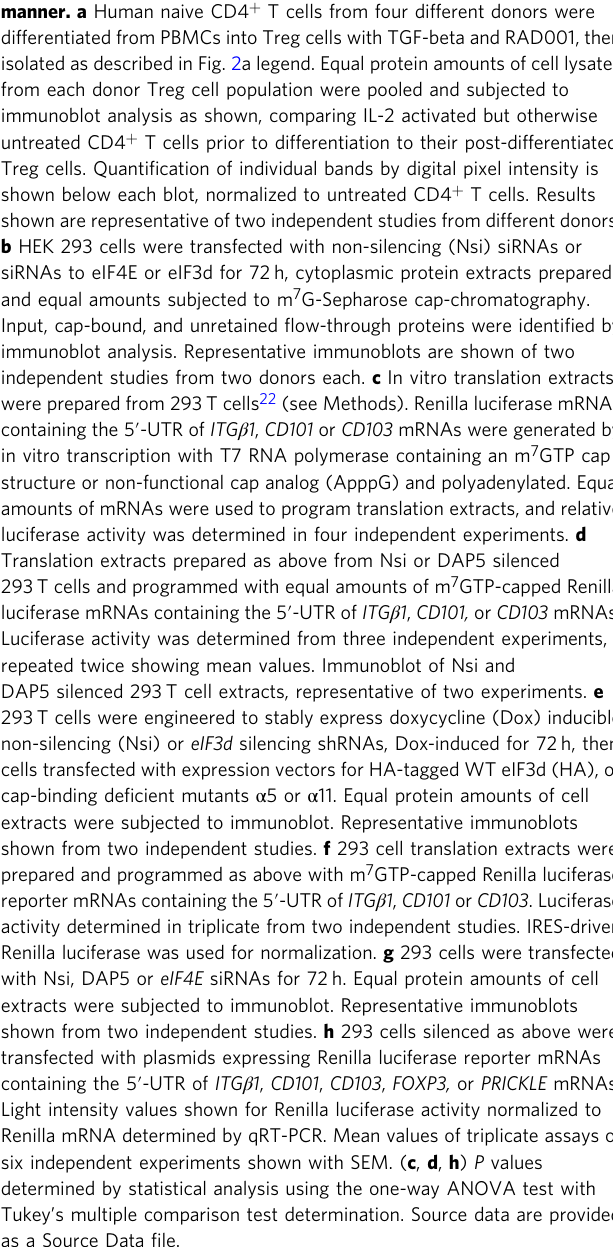
Fig. 7 Treg cell mRNAs are translated in a DAP5/eIF3d cap-dependent manner. a Human naive CD4 + T cells from four different donors were differentiated from PBMCs into Treg cells with TGF-beta and RAD001, then isolated as described in Fig. 2a legend. Equal protein amounts of cell lysates from each donor Treg cell population were pooled and subjected to immunoblot analysis as shown, comparing IL-2 activated but otherwise untreated CD4 + T cells prior to differentiation to their post-differentiated Treg cells. Quanti fi cation of individual bands by digital pixel intensity is shown below each blot, normalized to untreated CD4 + T cells. Results shown are representative of two independent studies from different donors.